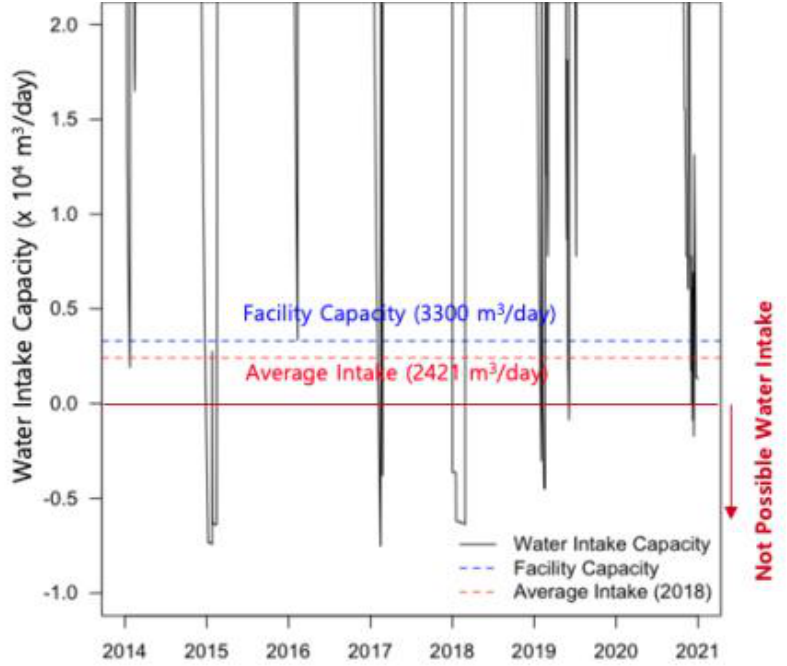
Figure 4. Water intake capacity (WIC) at the Hyunri water intake plant (HWIP) based on combining observed flow data with hydrologic simulations from 2014 to 2020.